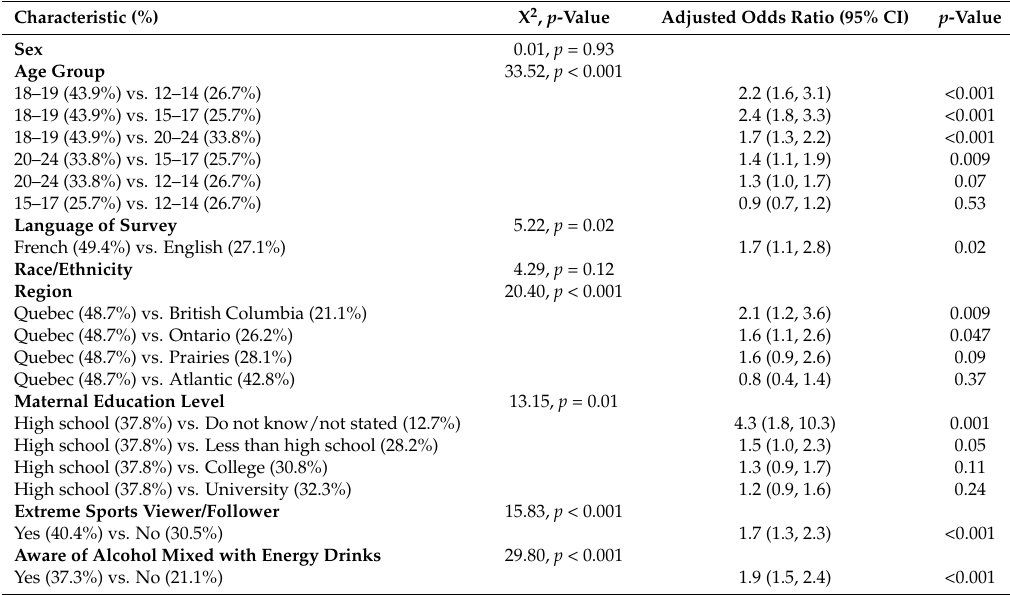
Table 4. Results from a logistic regression model, showing correlates of having ever seen an educational message that warns about the potential health risks of energy drinks ( n =